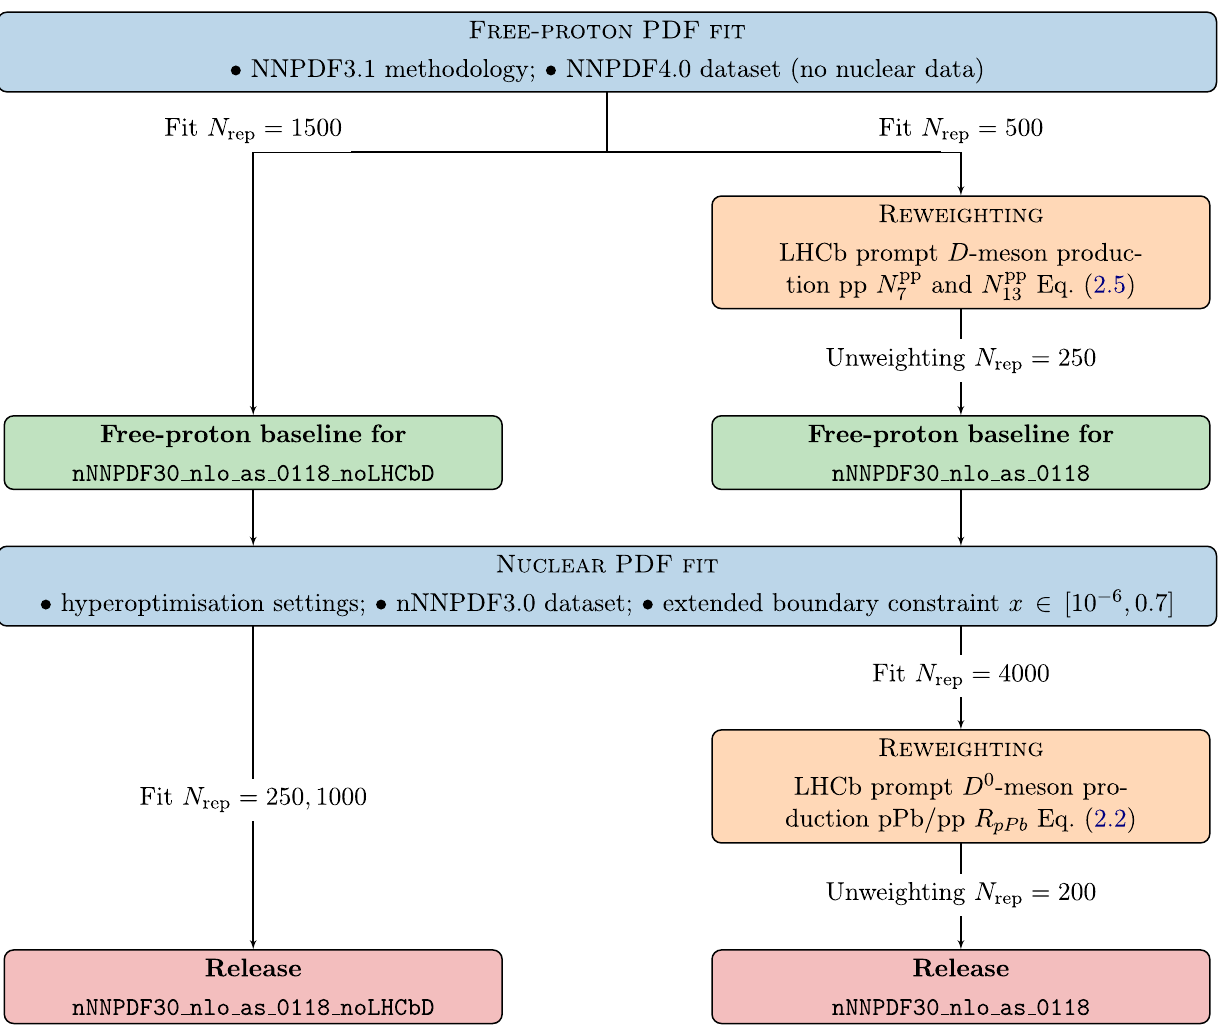
the A = 1 boundary condition). Then to assemble nNNPDF3.0 we start from the nNNPDF2.0 dataset, augment it with the NNPDF4.0 deuteron data and the new pPb LHC cross-sections, and produce a global nPDF fit with the hyperoptimised methodology. Finally this is reweighted by the LHCb D 0 meson production measurements in pPb collisions, and upon unweighting we obtain the final nNNPDF3.0 fits